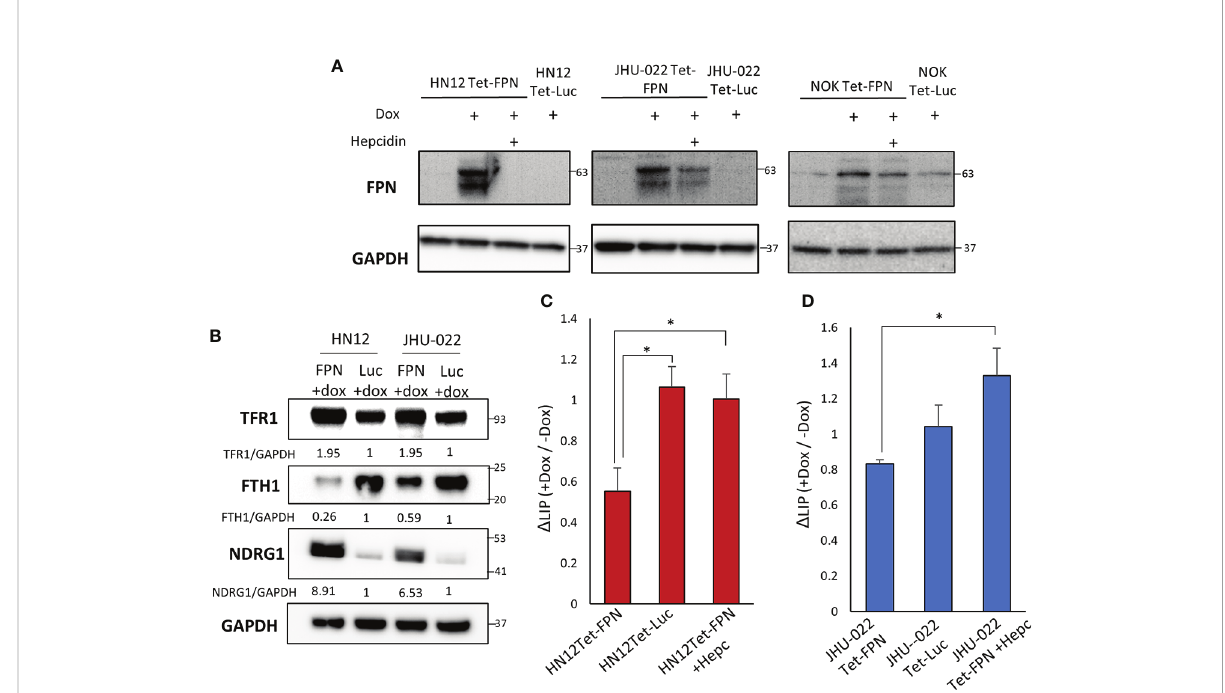
FIGURE 2 Stable Expression of FPN in the HN12, JHU-022, and NOK cell lines. (A) Western blot of FPN in the HN12-FPN/Luc, JHU-022-FPN/Luc, and NOK-FPN/Luc after treatment with 0.5 m g/mL of doxycycline for 48 hours. For rescue experiments, hepcidin was added to cell cultures with doxycycline at 20 m M. (B) HN12-FPN/Luc and JHU-022-FPN/Luc were stimulated with 0.5 m g/mL dox for 72 hours and blotted for iron related proteins transferrin receptor 1 (TfR1), ferritin heavy chain 1 (FTH1), or N-myc downstream regulated protein (NDRG1). Quanti fi cation of TFR1, FTH1, and NDRG1 was performed using GAPDH as a loading control and normalized to the Luc control line. (C) (D) Measurement of the labile iron pool in cells using 1 m M FerroOrange. Changes in the levels of labile iron are represented as ratios of induced (+dox) samples normalized to un-induced (- dox) samples. (*P<0.05). All data is representative of 3 biological